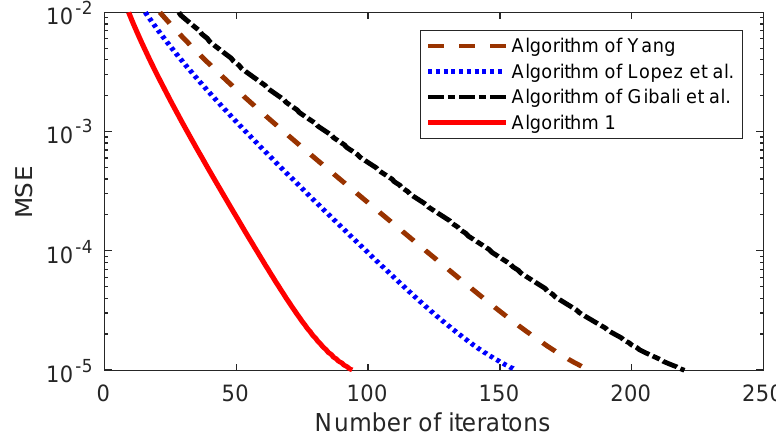
Figure 1. MSE versus number of iterations of Algorithm 1 in case N = 4096, M = 2048, and m = 200. Original signal (N=4096, M=2048 with 200 spikes)